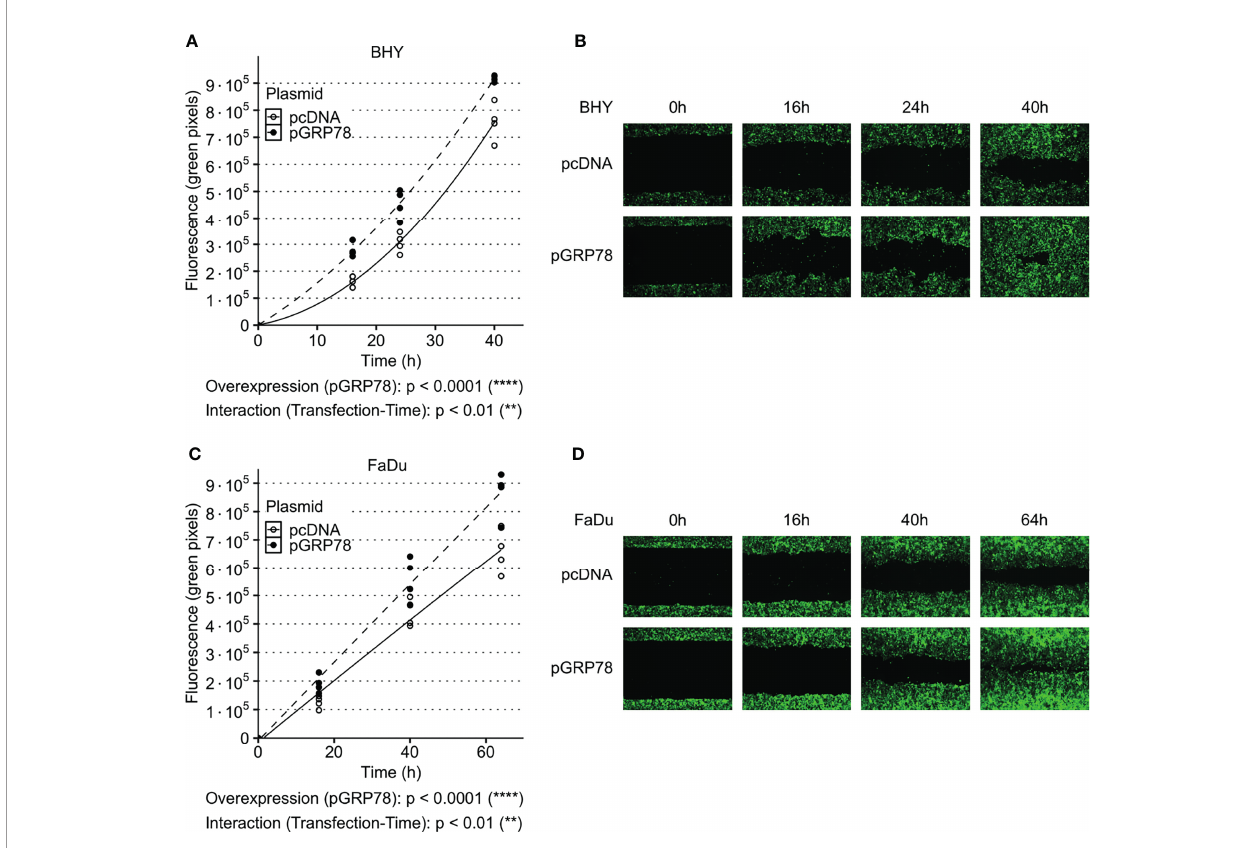
FIGURE 4 | Increased migration of HNSCC cells after overexpression of GRP78. (A – D) Cell migration analysis (gap fi lling) of GFP-expressing BHY (A, B) and FaDu (C, D) cells. Both cell lines show an increase in migration after overexpression of GRP78 in comparison to control. Cells were transfected with GRP78 plasmid (pGRP78) 72 h prior to migration analysis. Cells transfected with an empty vector (pcDNA) were used as control (n = 4, Two-way RM